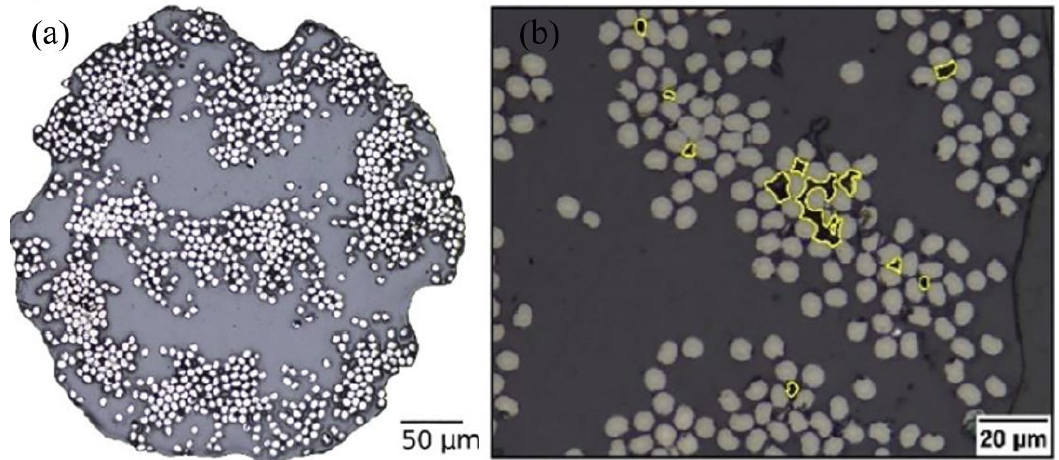
Figure 13. ( a ) Cross-section of continuous CF reinforced filament. ( b ) Magnified image representing voids between fibres [202].